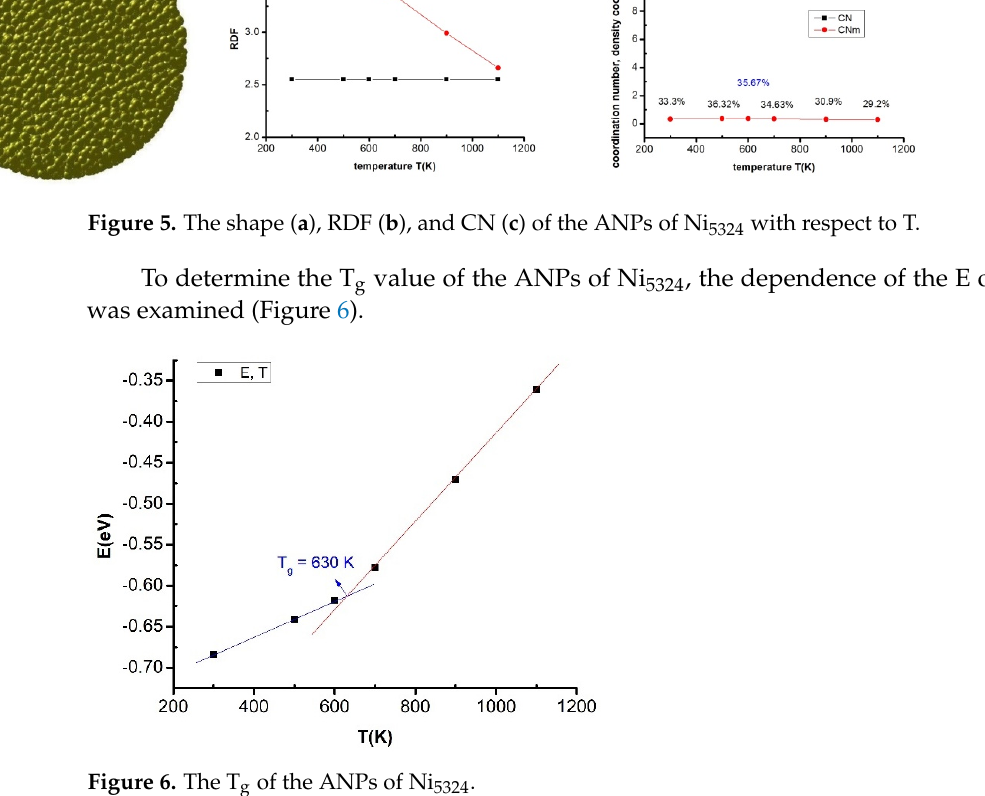
Figure 6. The T g of the ANPs of Ni 5324 .